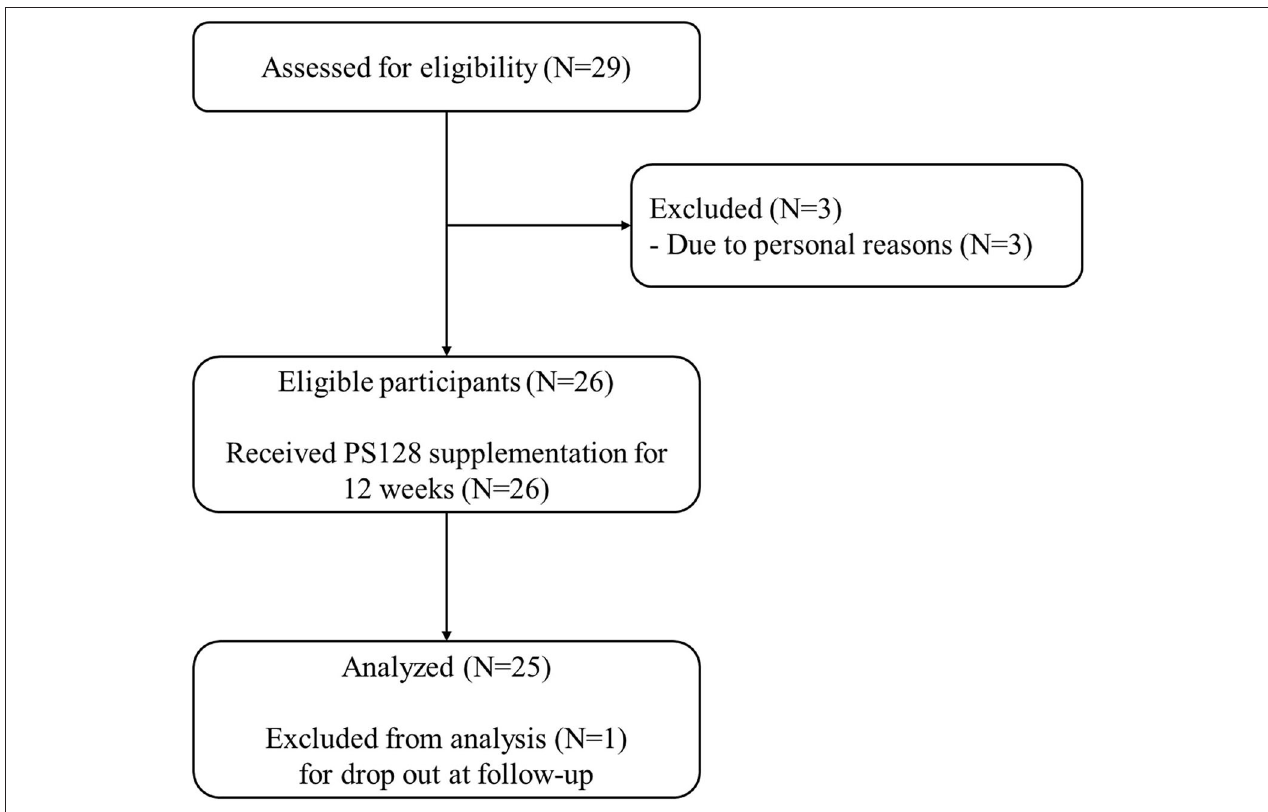
FIGURE 1 | Study flow